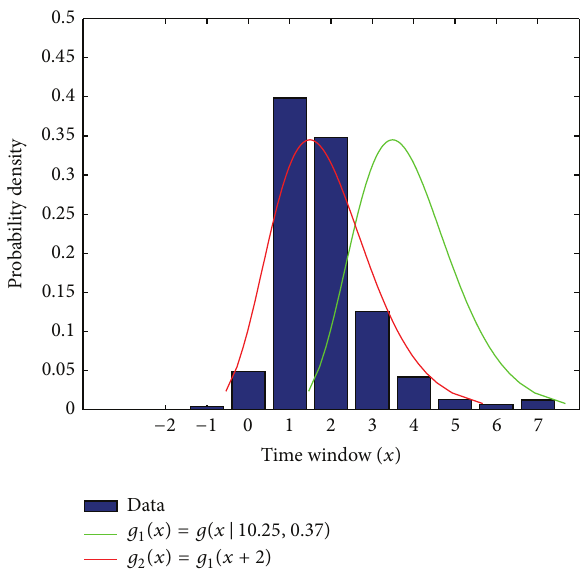
Figure 4: Distribution of arrival time windows according to estimated time of arrivals, which can be approximated by 𝑔 2 (𝑥) ∼ 𝑓 gamma ETA